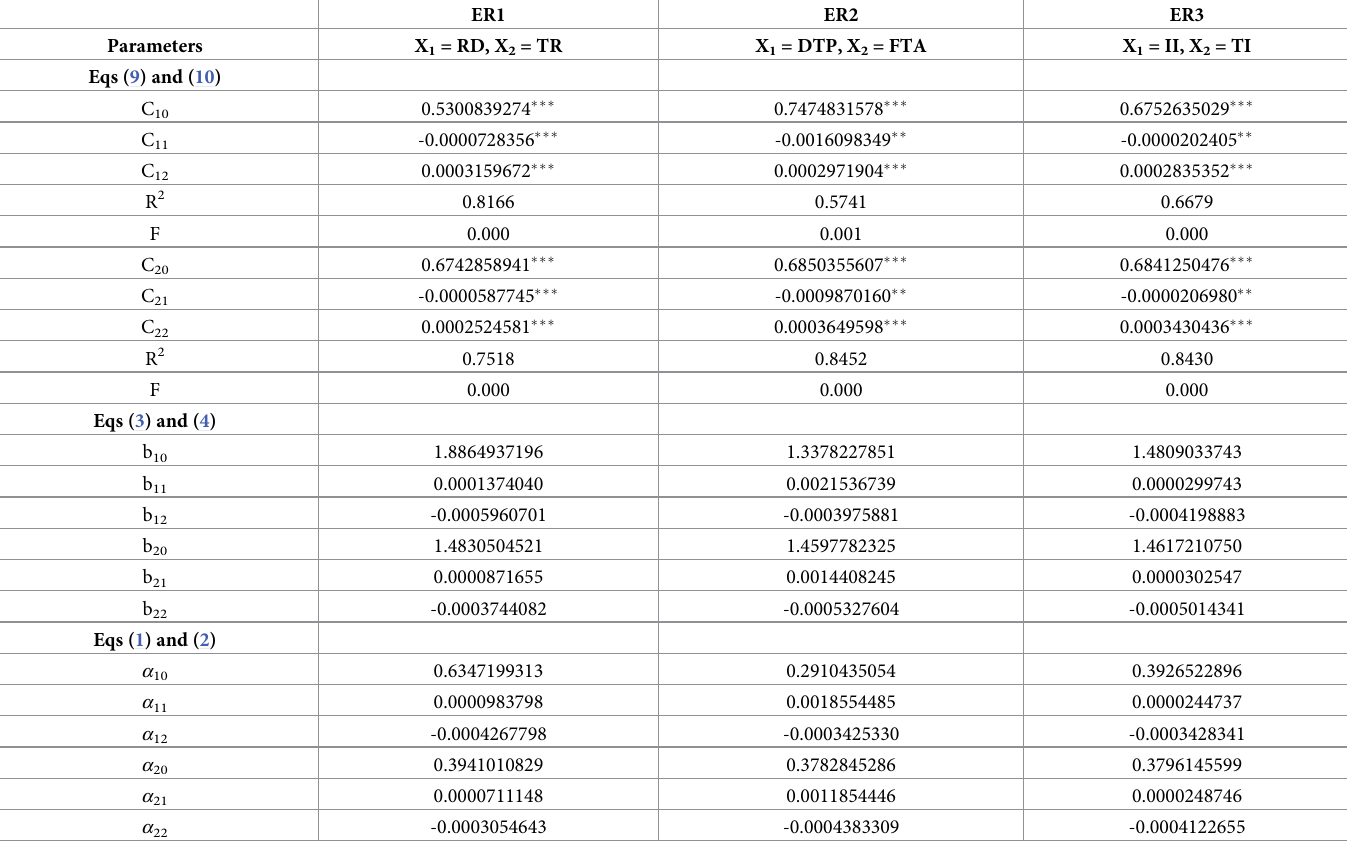
Note � , �� and ��� denote significance of p-values at the 0.1, 0.05 and 0.01 levels,